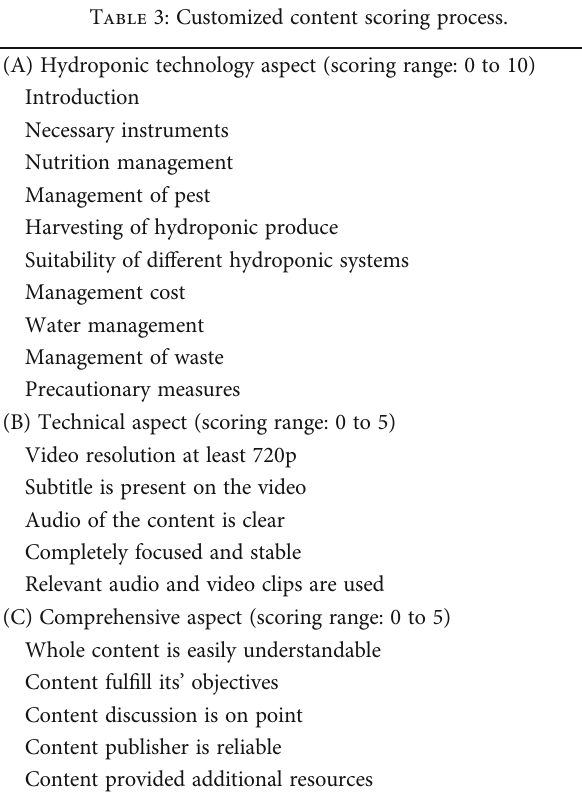
Table 3: Customized content scoring